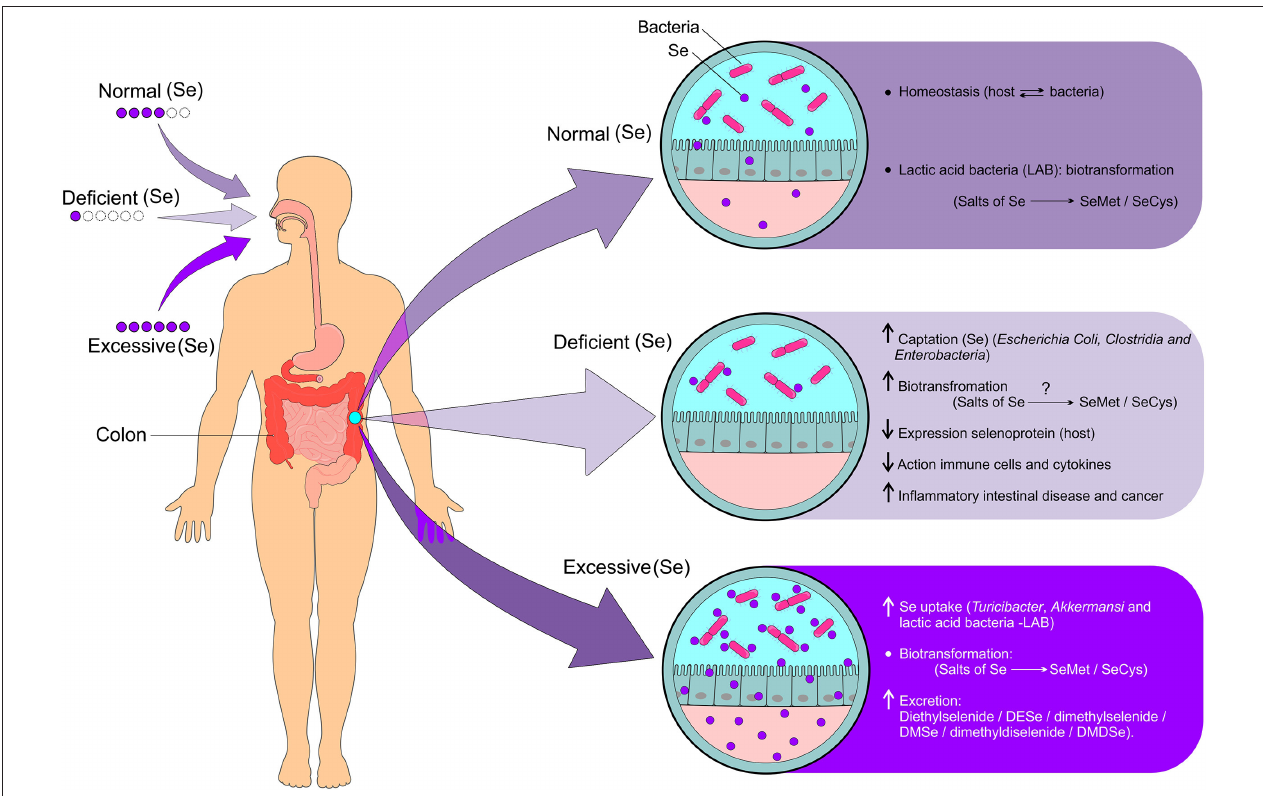
FIGURE 5 | Modulation of the gut microbiota dependent on Se status and biotransformation of Se derivatives. Given the adequate intake of Se, homeostasis occurs due to the beneficial relationship between intestinal and host bacteria resulting in the biotransformation of Se compounds (Se salts metabolized into SeMet and SeCys). Se deficiency results in increased Se uptake by bacteria ( Escherichia coli, Clostridia, and Enterobacteria ), biotransformation of Se compounds (Se salts metabolized into SeMet and SeCys), decreased expression of selenoproteins by the host, decreased activation of Se immune cells, increased